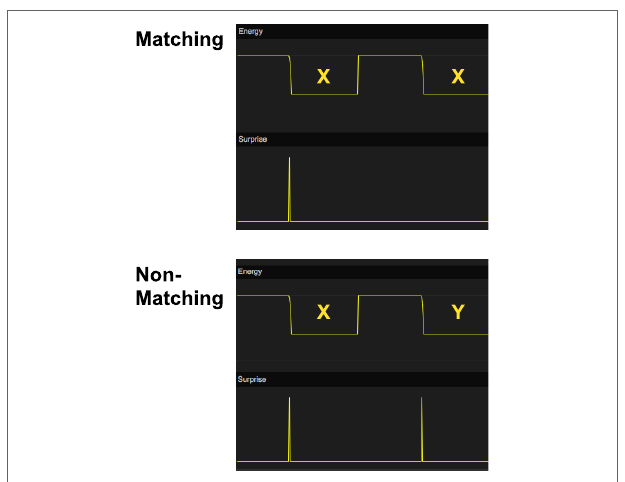
FigUre 7 | Simulation of delayed matching to sample (DMTS). In the top graph, the stimulus X is first shown as a sample stimulus and is subsequently followed by X again as comparison stimulus. There is no surprise signal the second time X is shown, indicating that the model recalls that it has seen this stimulus before. In the bottom graph, the sample stimulus X is followed by comparison stimulus Y instead. In this case, there is a surprise signal for the non-matching stimulus. The energy function is used to show the timing of the